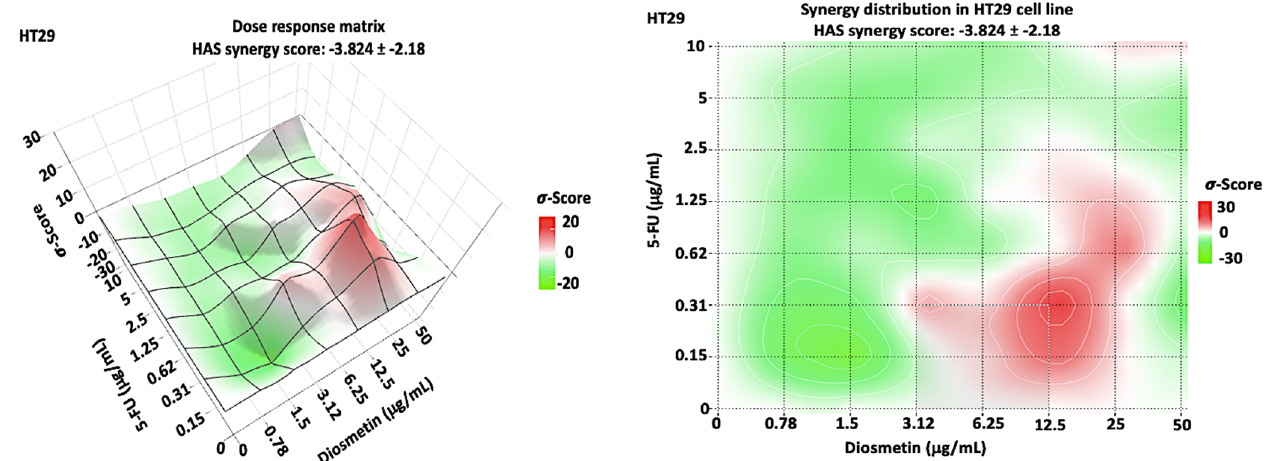
Figure 10. Dose–response matrix and synergy distribution in HT29 cells treated with combination therapy. SynergyFinder 2.0 software was used for this analysis. Data were obtained from three individual experiments. The mean synergy score was − 3.824 ± − 2.18.